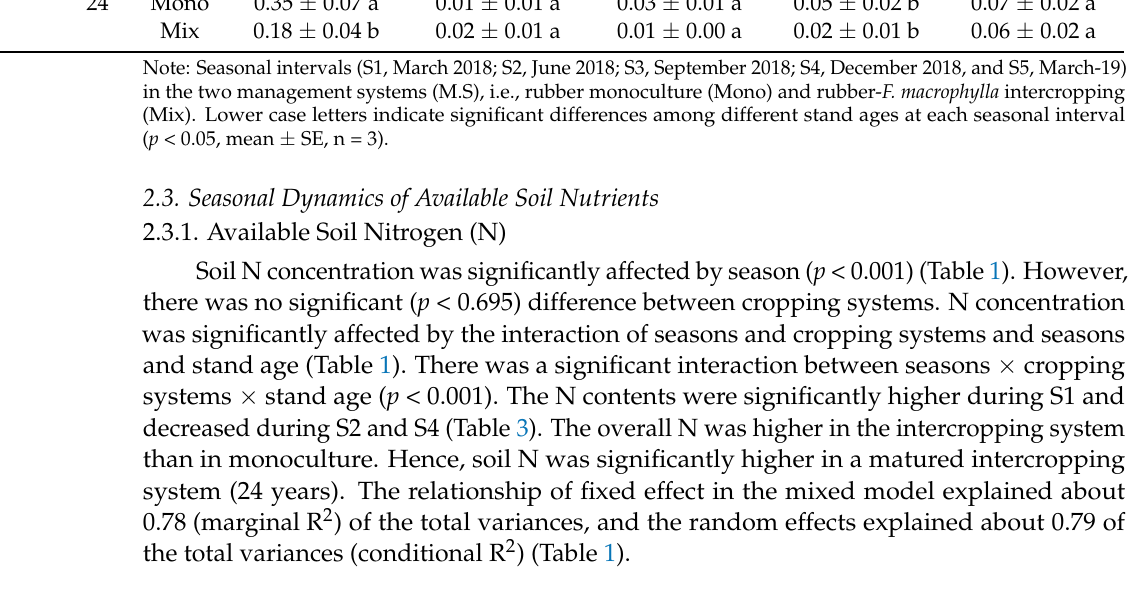
Table 3. Available nutrients (N, P, and K) concentrations in different seasonal intervals in the two- management